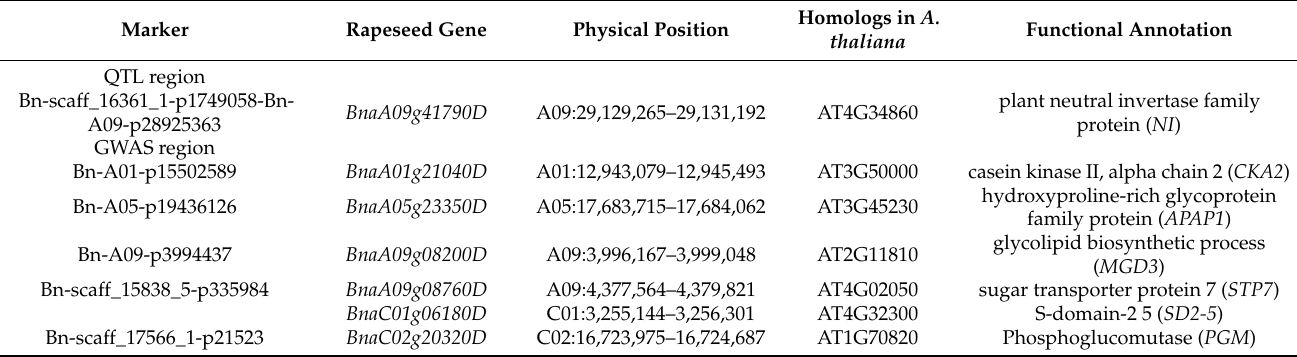
Table 4. Candidate gene information of soluble solids content associated loci in B. napus shoots. Marker Rapeseed Gene Physical Position